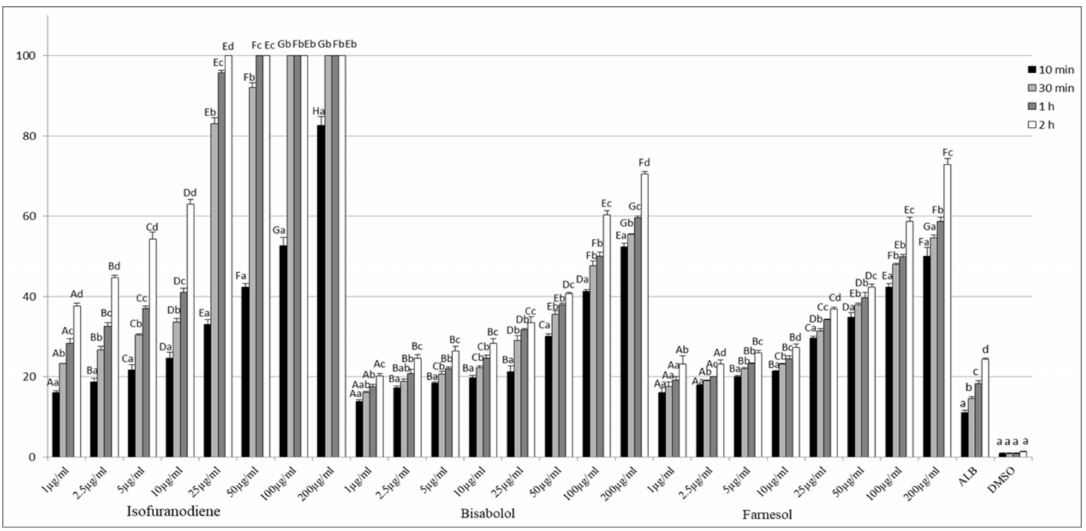
Figure 2. Mortality (%) of E. granulosus protoscoleces over di ff erent times of exposure to isofuranodiene, α -bisabolol, and farnesol. Within each concentration of tested compounds, columns marked with di ff erent letters (lowercase) are significantly di ff erent between times of exposure (Repeated measures ANOVA, Bonferroni test, p < 0.05). Within each tested compound, columns marked with di ff erent letters (uppercase) at each time of exposure (10 min, 30 min, 1 h, and 2 h, separately) are significantly di ff erent between concentrations (ANOVA, Tukey’s HSD test, p <